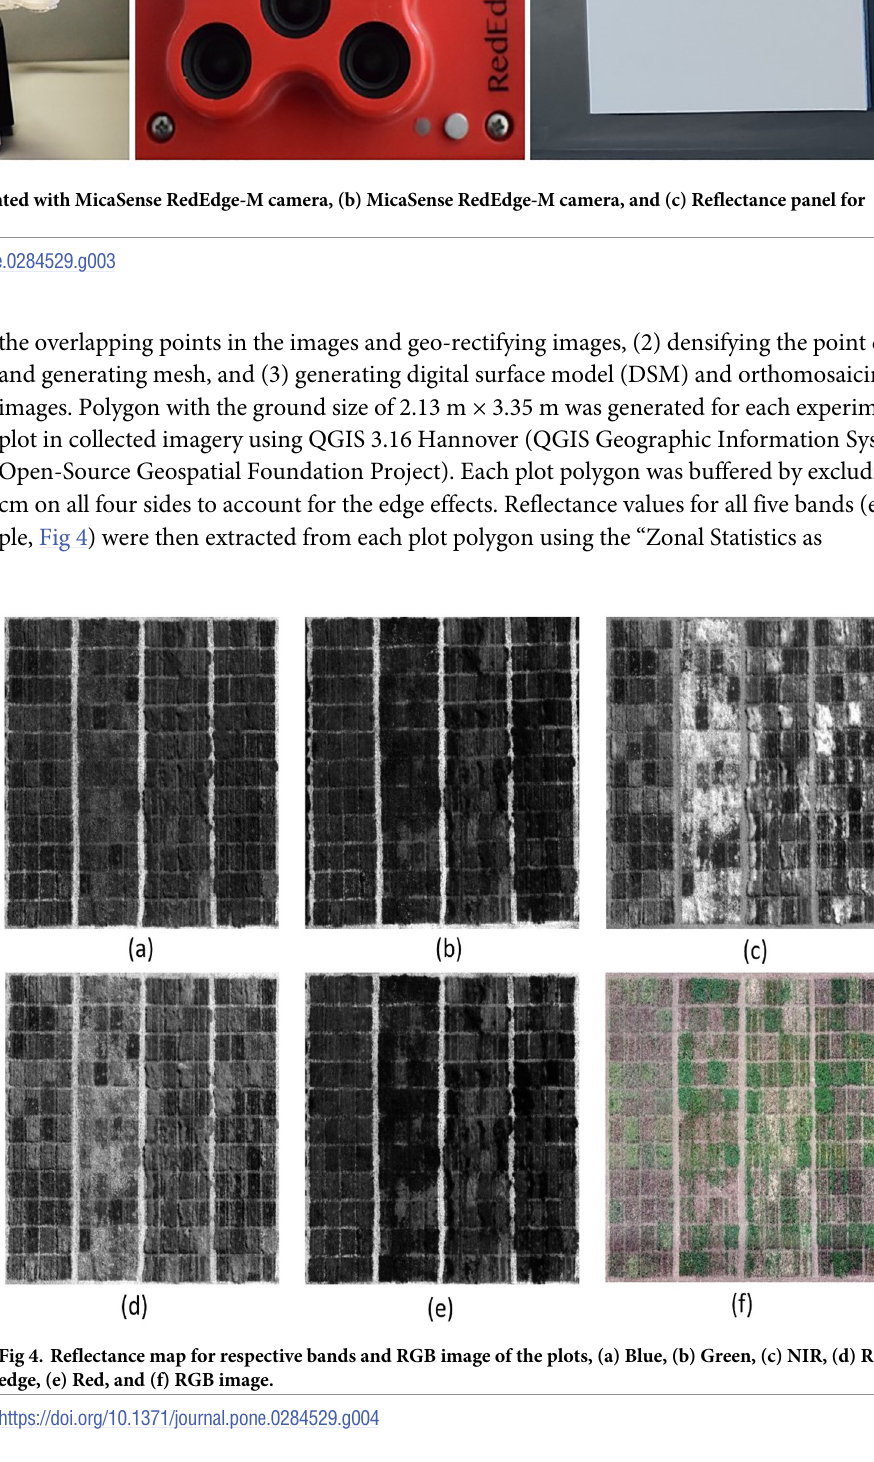
Fig 4. Reflectance map for respective bands and RGB image of the plots, (a) Blue, (b) Green, (c) NIR, (d) Red- edge, (e) Red, and (f) RGB image.